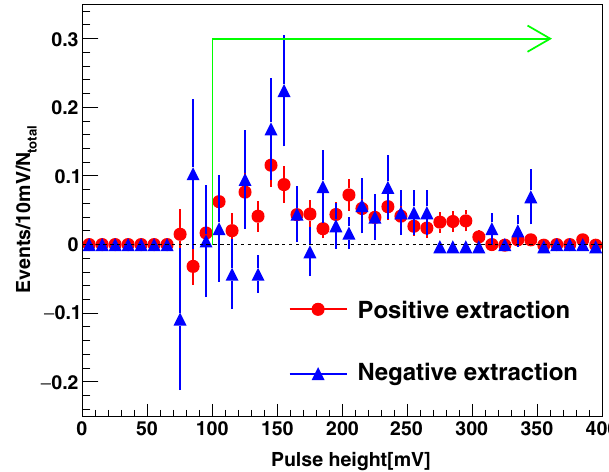
FIG. 6. Two-dimensional distribution of the ToF and the pulse height of the negative extraction. The number of incident μ þ ’ s was 2 . 7 × 10 10 .